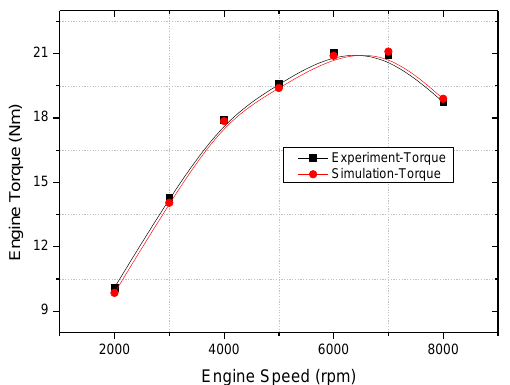
Figure 8. Brake torque following engine speed.